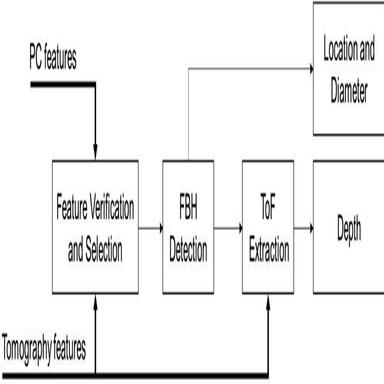
Process block diagram of FBH evaluation based on PC and tomography features.